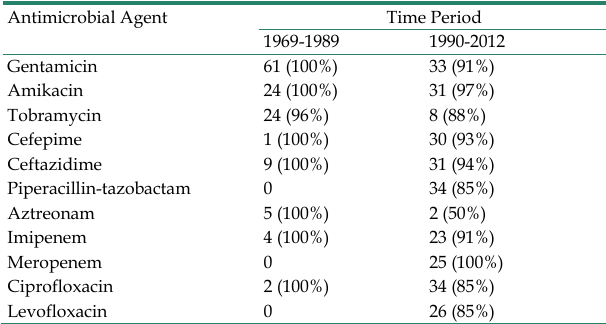
Table 2 . In vitro susceptibilities of selected antimicrobials against Pseudomonas isolates in 91 patients with PS PJI, by time